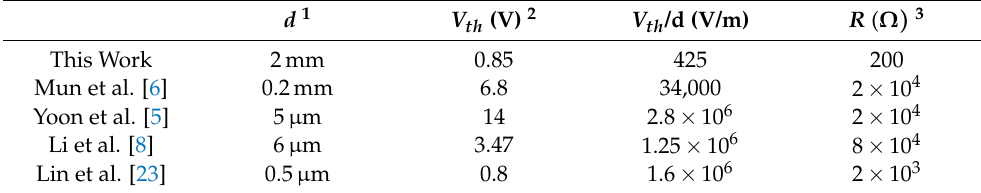
Table 1. Comparison of this work to other studies investigating a Joule heating-induced resistive switch in VO 2 . Note in this work the low R and the correlated exceptionally low V th / d . V th in this work is comparable to others due to the large d . d 1 V th (V) 2 V th /d (V/m) R ( Ω ) 3 2mm 0.85 425 200 0.2mm 6.8